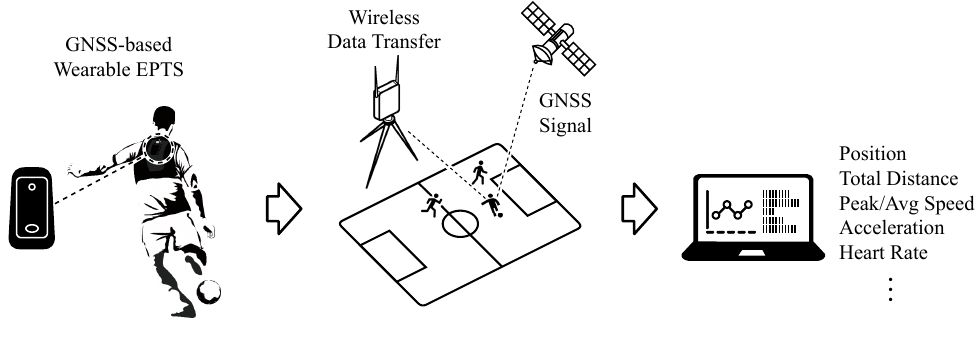
Figure 1. A wearable electrical performance tracking system (EPTS) in football